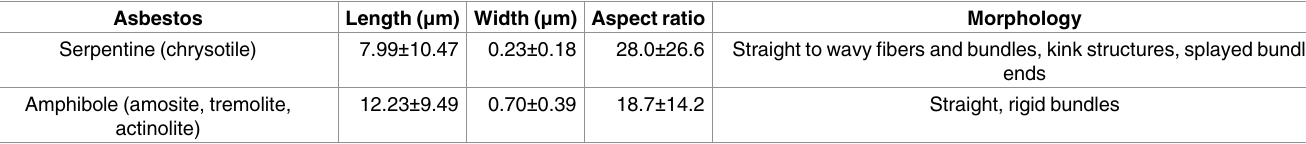
Table 1. General characteristics of the asbestos used in the